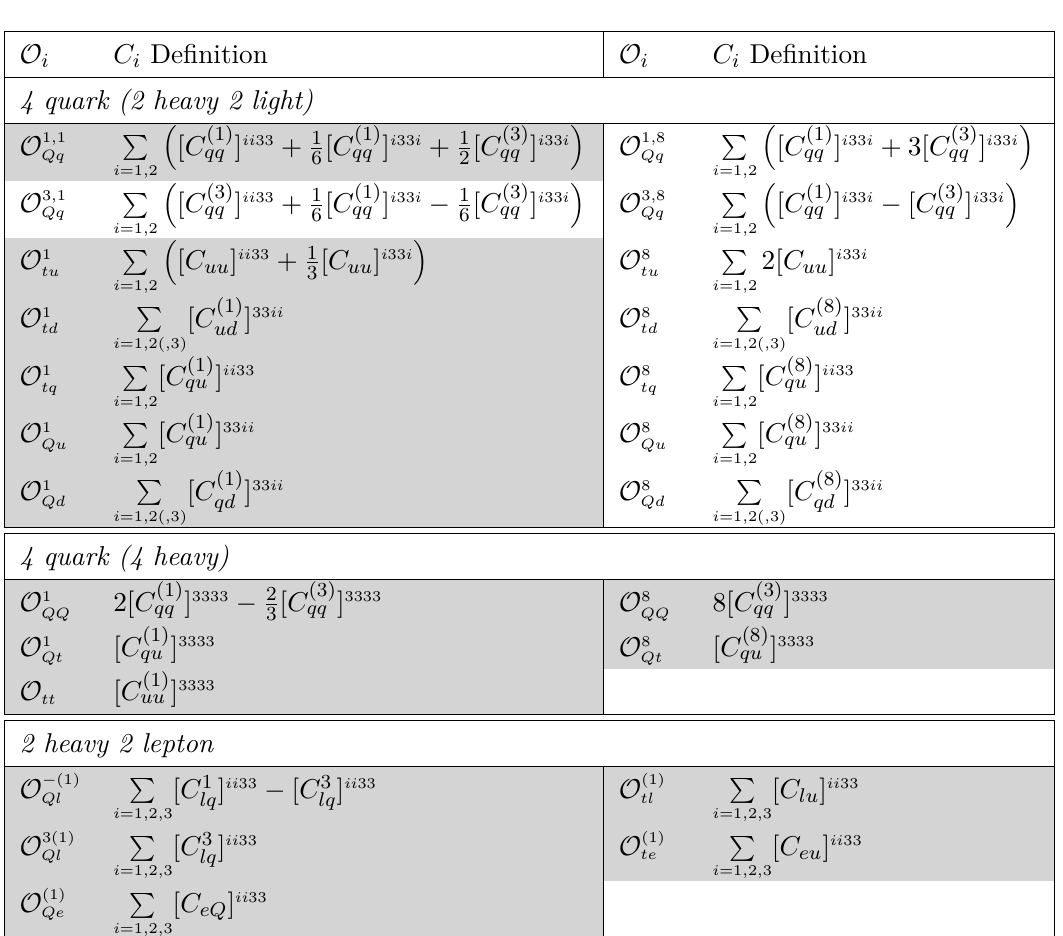
Table 2 . Four-fermion operators containing at least one third-generation bilinear in the ‘dim6top’ basis [183] assuming an SU(2) 2 × SU(3) 3 flavour symmetry. The relations of the corresponding Wilson coefficients with those of the Warsaw basis are also shown. The shaded entries indicate operators that are not included in our analysis because significant constraints cannot be obtained from the chosen dataset at leading order and linear level in the EFT expansion, as discussed in the